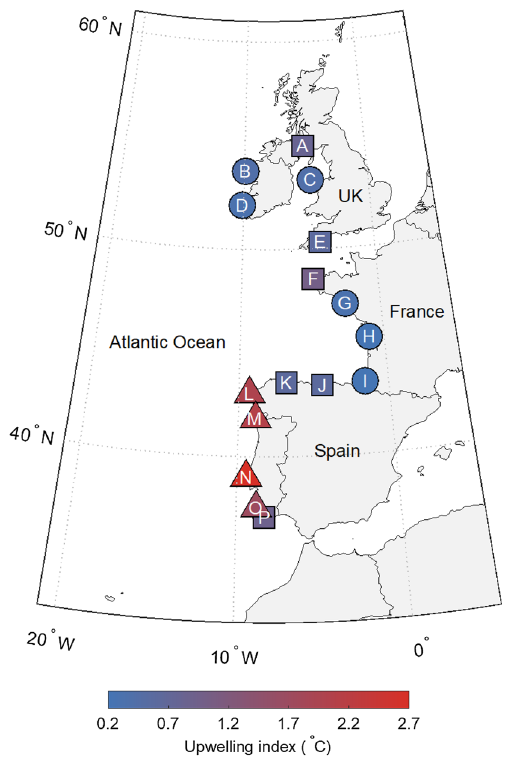
Figure 1. Map of the study sites. Letters A-P indicate the locations of the 16 sites where temperature logger data were collected, which covers the broad range of Patella vulgata’s southern distribution. Sites are labeled in descending order from Northernmost to Southernmost latitudes, where: A—South Cairn, UK; B—Emlagh, IE; C—Anglesey, UK; D—Minard Castle, IE; E—Wembury, UK; F—Landunvez, FR; G—Le Croisic, FR; H—Royan, FR; I—Biarritz, FR; J—San Vicente de la Barquera, ES; K—La Caridad, ES; L—Cabo Touriñan, ES; M—Moledo, PT; N—São Lourenço, PT; O—Alteirinhos, PT; P—Evaristo, PT. Colors represent the thermal upwelling index, which ranges from low upwelling (blue) to strong upwelling (red). Circles represent sites characterized by no upwelling (0.0–0.4), squares represent weak upwelling (0.5–1.0), and triangles represent strong upwelling (1.1–3.0). Map was created in MATLAB, version 9.11 108